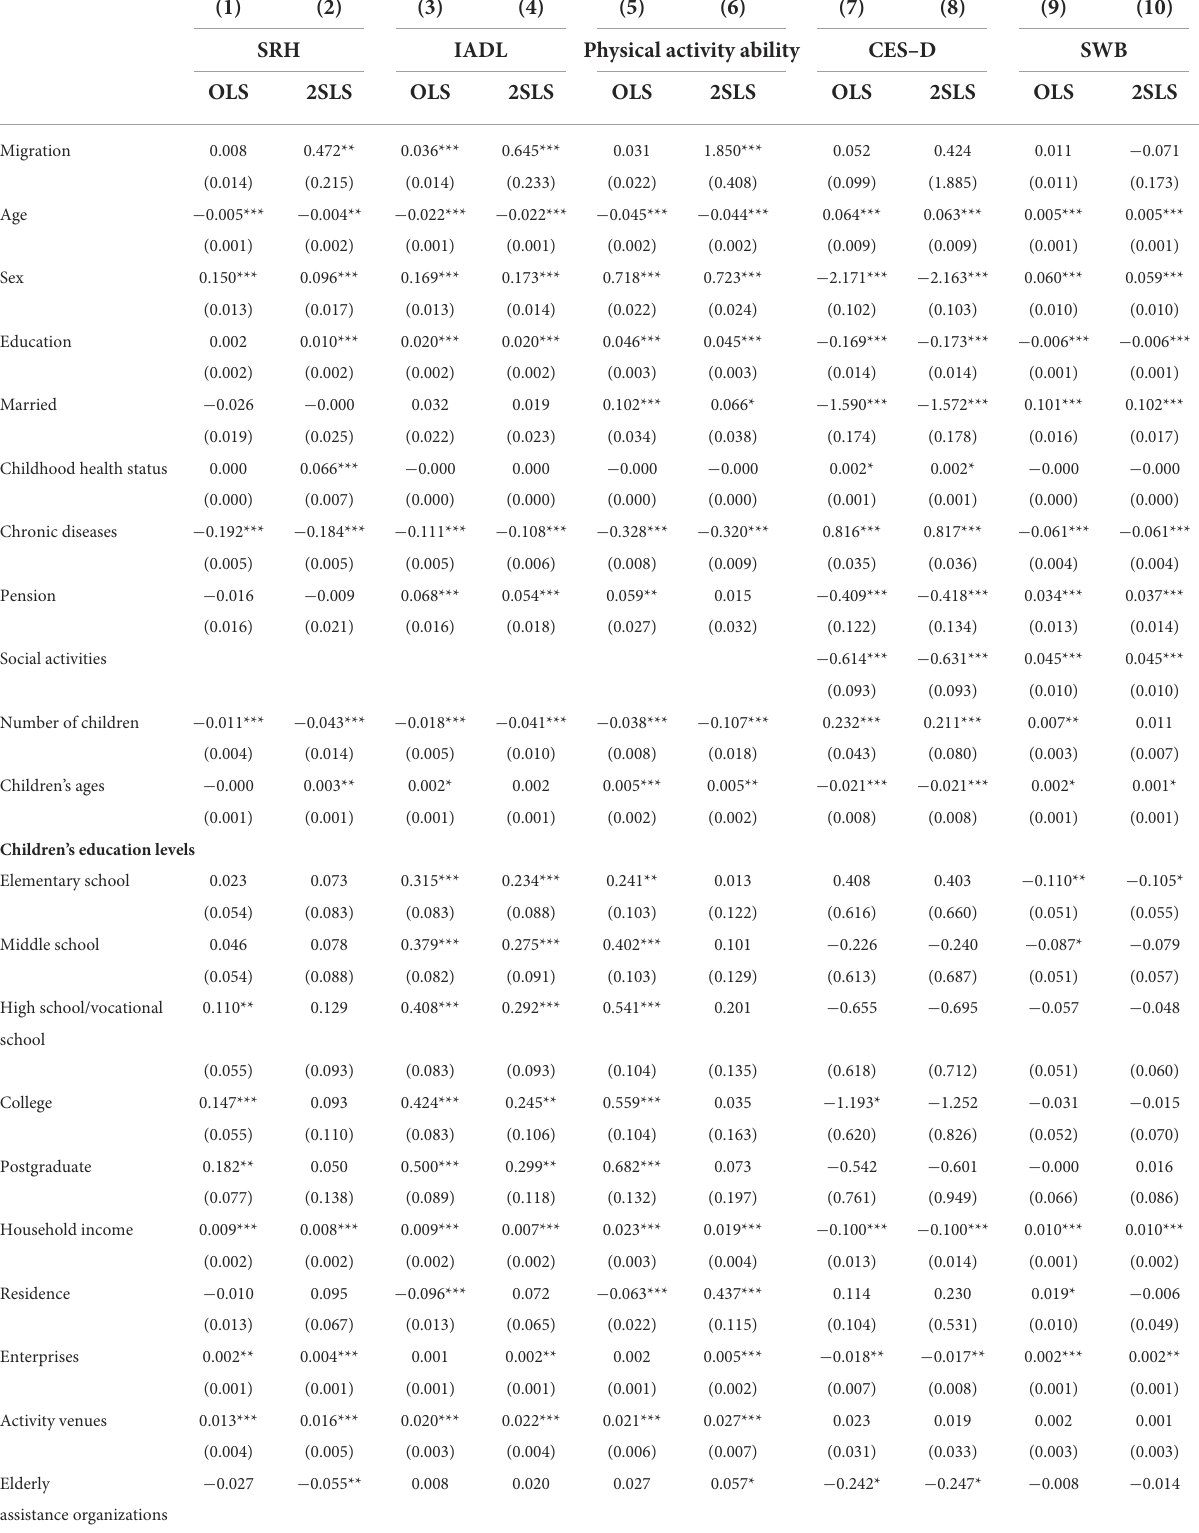
TABLE 3 Estimated results of the impact of migration on parents’ health in rural